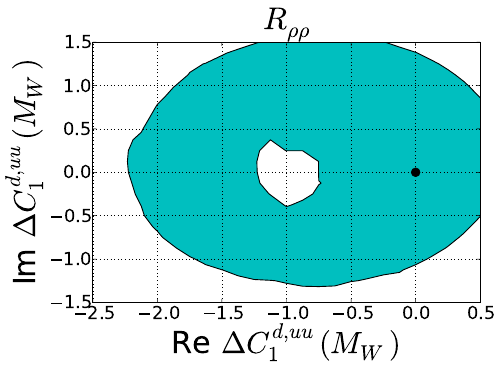
Figure 10 . Potential regions for the NP contributions in (cid:1) C d;uu R (cid:26)(cid:26) at 90% C.L. . The bounds on (cid:1) C d;uu point corresponds to the SM